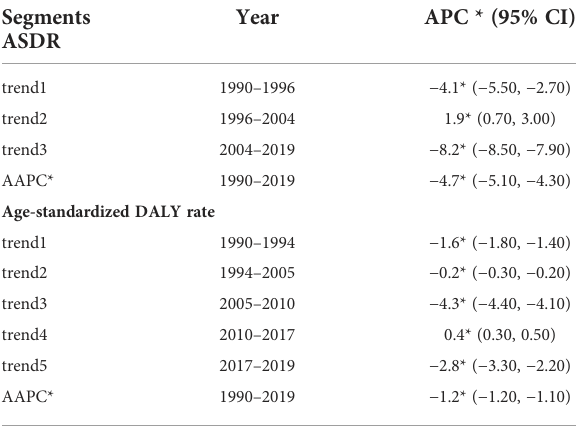
TABLE 1 Trends in endometriosis death and DALY rates in China, 1990 – 2019. Segments